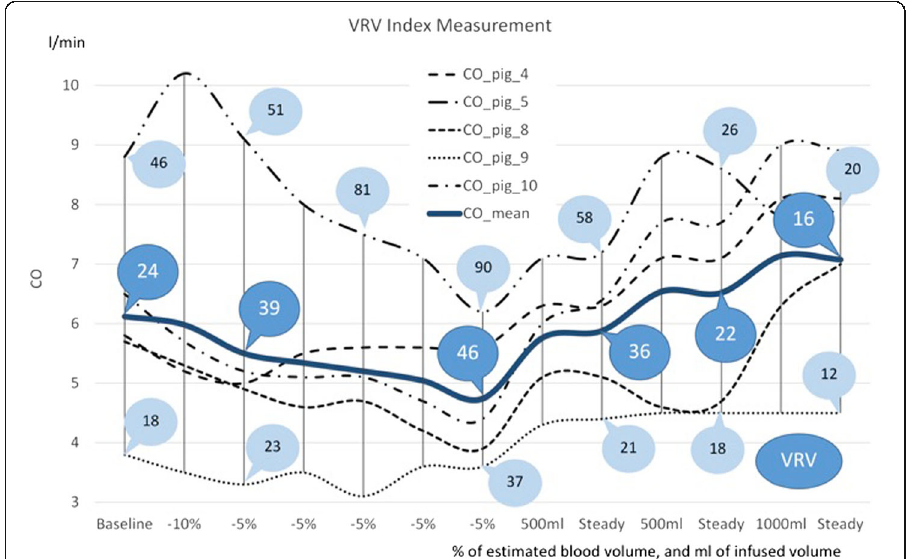
Fig. 2 Changes in VRV index during the study. The “ X ” axis represents changes in volume status (bleeding in percent of estimated blood volume, two times reinfusion with 500 ml of blood, 1000 ml of saline infusion). The “ Y ” axis represents cardiac output in liters per minute measured by CCO (SwanGanz catheter). Numbers in circles are VRV indexes. This figure was done using data from five animals. VRV venous return variation index, CO cardiac